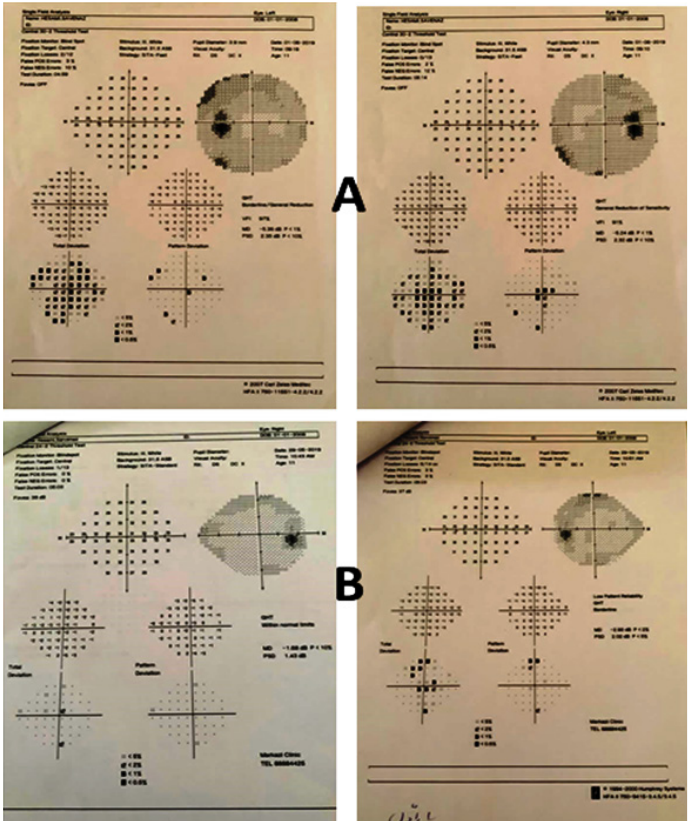
Figure 3. (A) Enlargement of bilateral blind spot in visual field, (B) After successful medical therapy visual field defect disappeared.